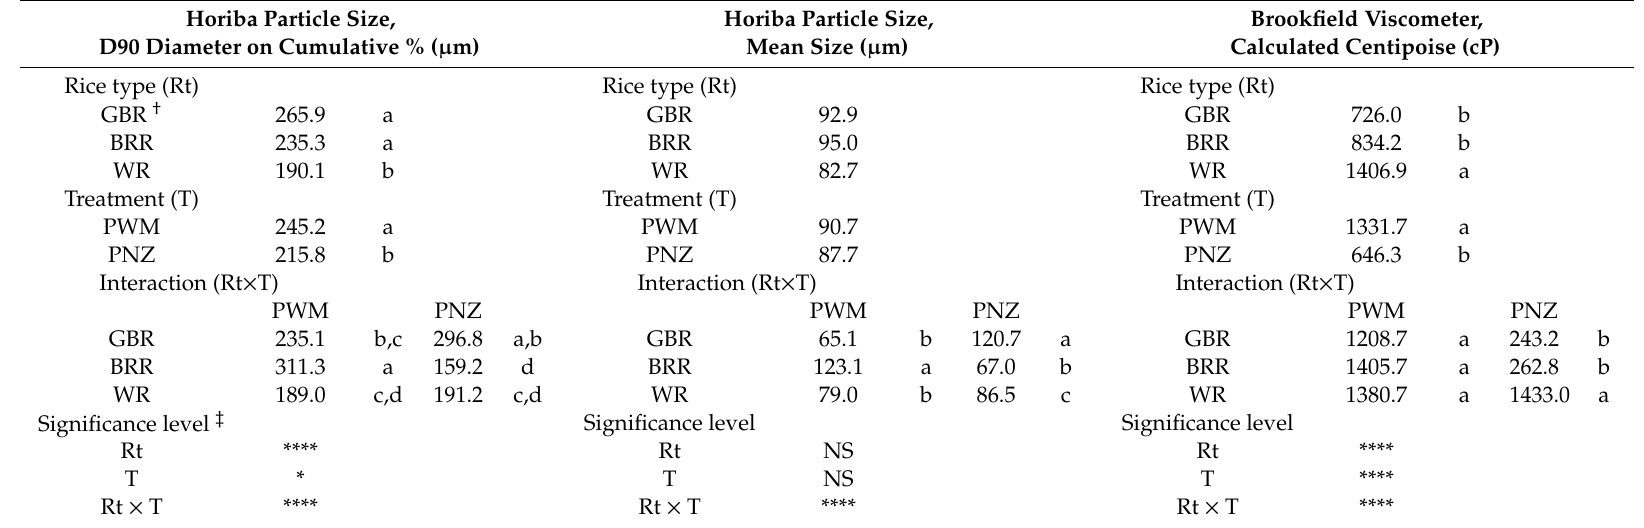
Table 3. Factorial analysis for rondo rice type and treatment e ff ects in selected particle size and viscometer parameters in germinated brown rice beverages produced through green technologies, compared to brown rice and white rice subjected to the same processing, without